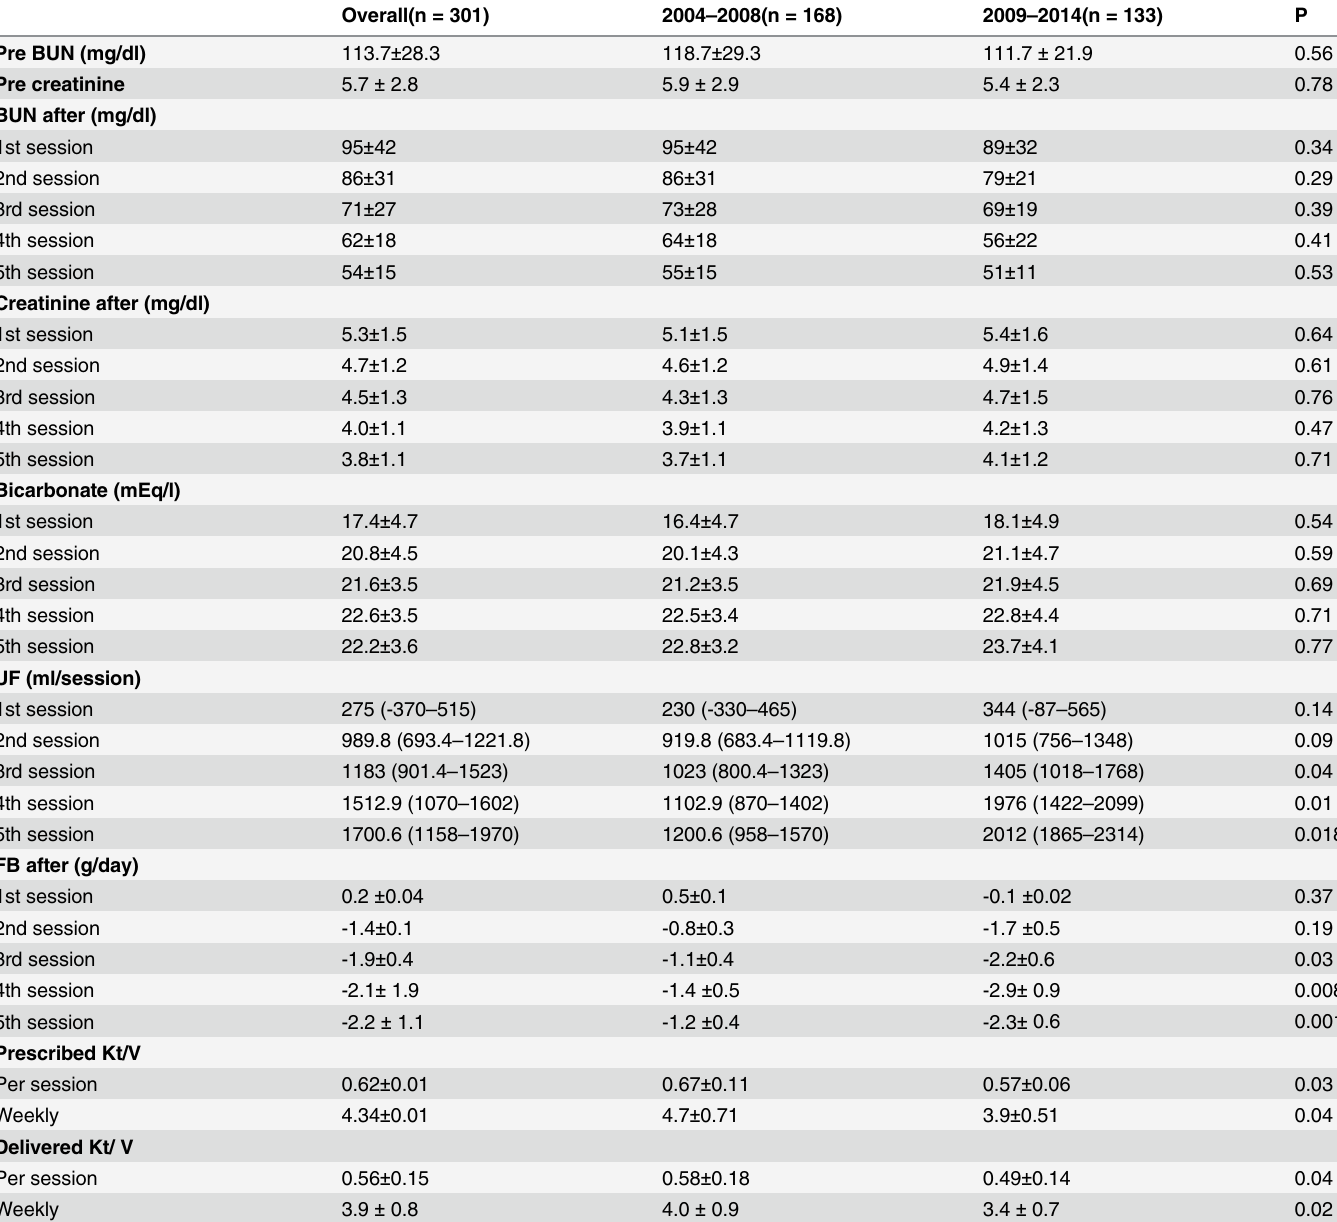
Table 2. Prescription and metabolic and fluid control of acute kidney injury patient treated with high volume peritoneal dialysis according to time